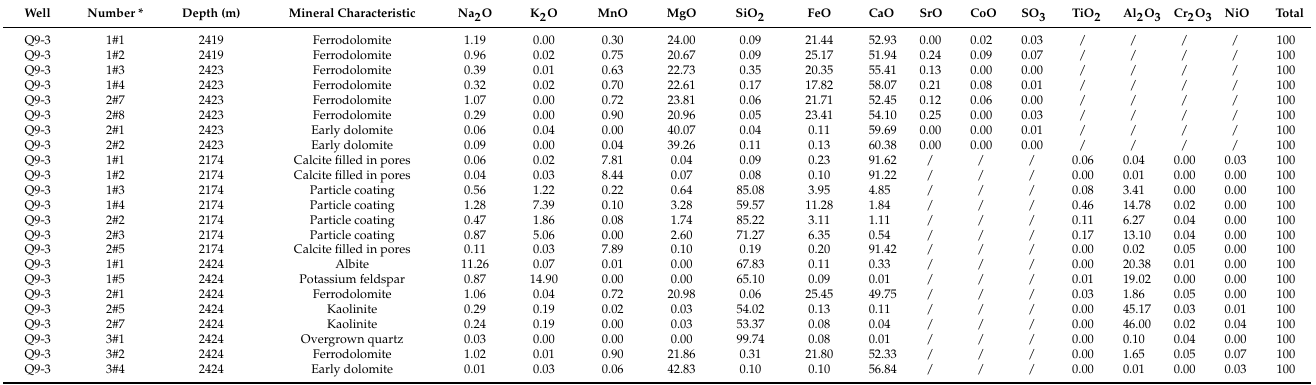
Table 1. The chemical composition (mass fraction, wt%) of minerals in the study